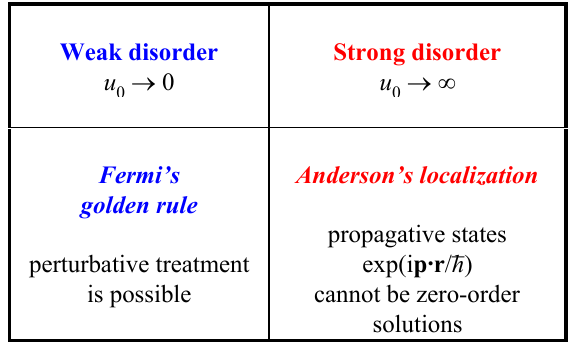
Table 3 . Weak vs strong disordered